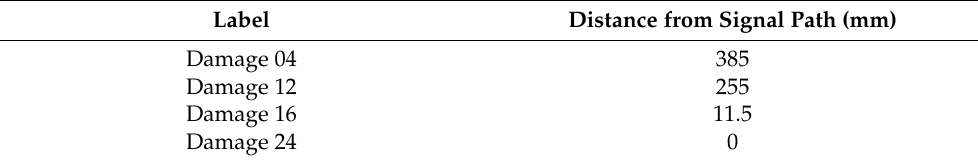
Table 8. Distance of the damage locations from the signal path between transducers 1 and 7.